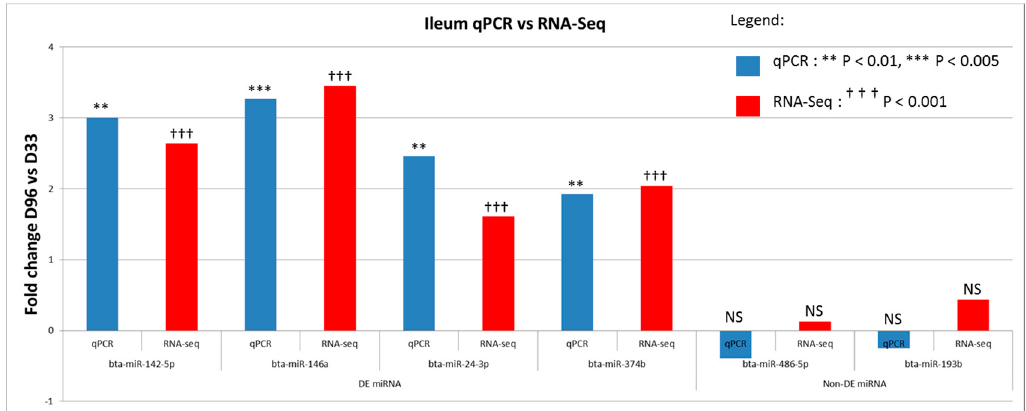
Figure 7. Result of qPCR validation of the expression of miRNAs between day 33 (pre-weaning) and day 96 (post-weaning), and compared with results obtained by miRNA sequencing.